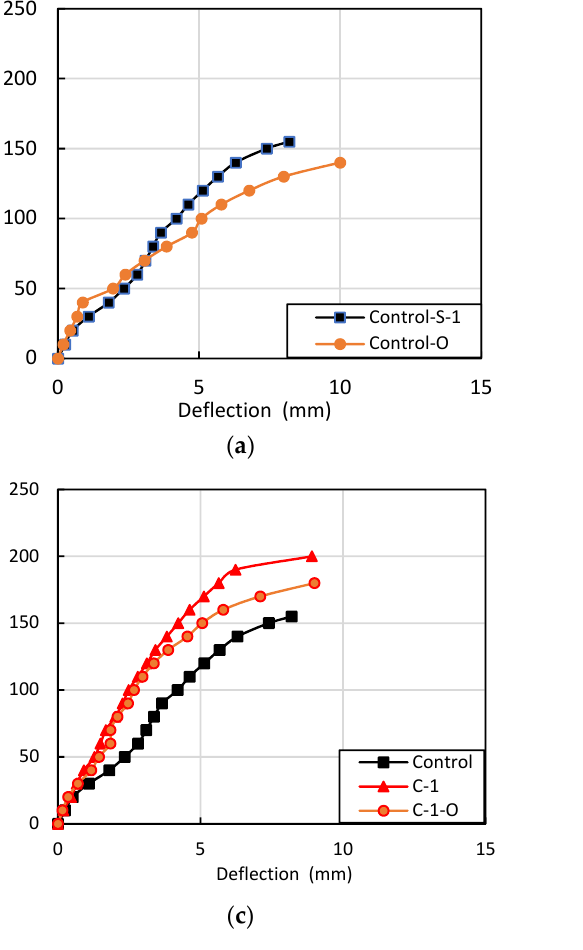
( b ) Figure 10. Load–Deflection with different types of fiber. ( a ) Solid slab; ( b ) Slab with opening.